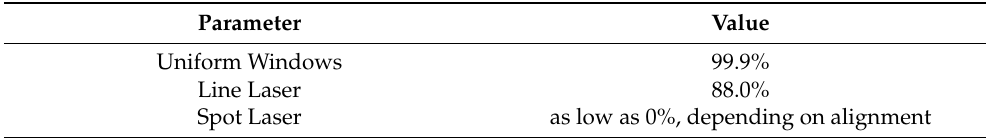
Table 7. Comparison of power lost for different illumination